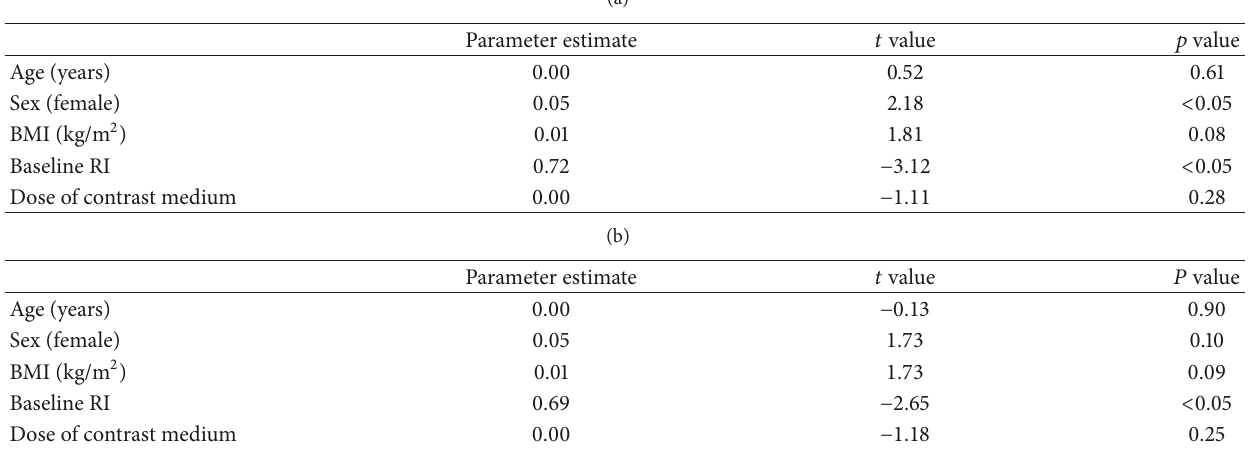
Table 4: Multivariate linear regression analysis of predictive and confounding factors for regression of eGFR. A: all subjects ( 𝑛 = 35 ); B: atherosclerotic RAS only ( 𝑛 = 30 ); BMI: body mass index; RI: resistive index; eGFR: estimated glomerular filtration rate. eGFR was